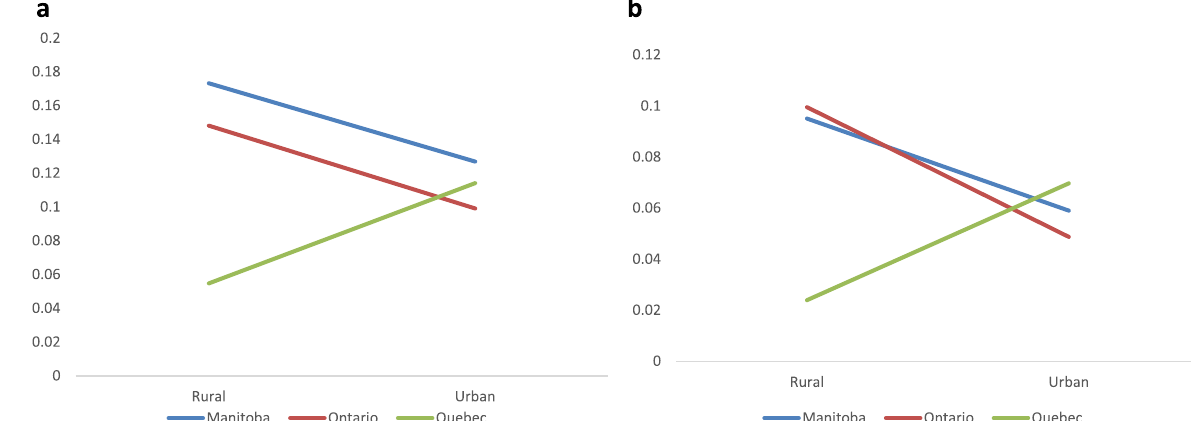
Fig. 2 a Probability of operating a motor vehicle after using cannabis, lifetime. b Probabilityof operating motor vehicle after using